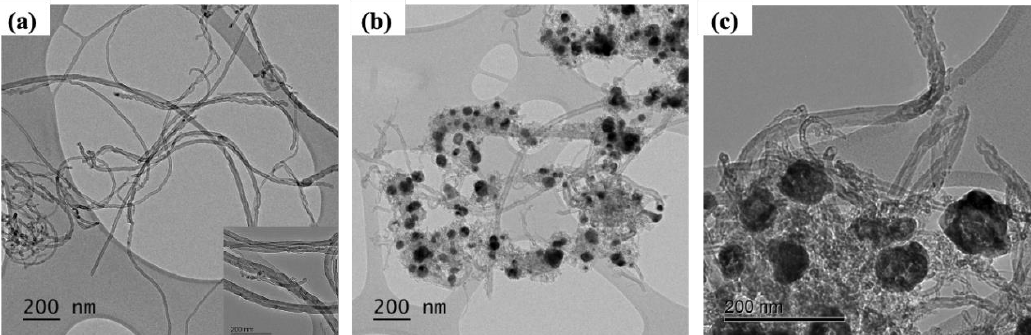
Figure 2. TEM images of ( a ) pristine carbon nanotubes (CNTs), ( b ) low- and ( c ) high-magnification images of ZIF-67 synthesized onto CNTs after carbonization. The inset of ( a ) is a high-magnification image of pristine CNTs.